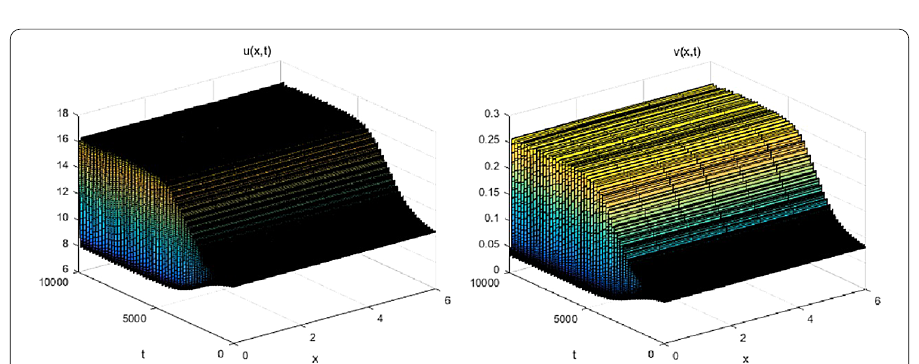
Figure 4 The numerical simulations of system (1.4) with parameters in (4.1) and d 1 = 0.006, d 2 = 0.002, r 1 = 0.02. Left: component u is stable. Right: component v is stable